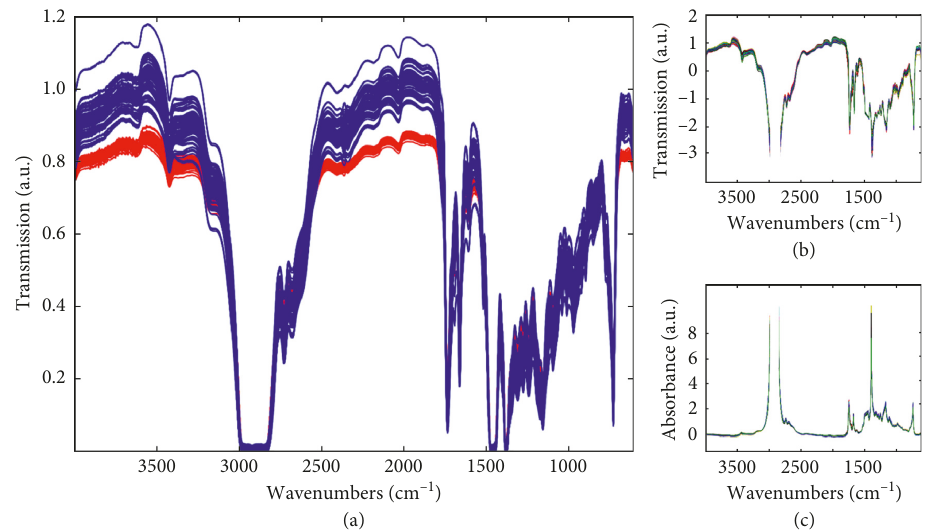
Figure 1: FTIR spectra of ATF. (a) Raw full transmission spectra without any preprocessing. The two data sets with different measurement setups can be discriminated by eye. The blue spectra originate from measurement type (1) with two KBr discs separated by a Teflon spacer, and the red set of curves originates from the cuvette measurement (2). (b) SNV-transformed transmission spectra after truncation of the saturated C-H vibrational regions and CO 2 areas and (c) SNV-transformed absorbance spectra after truncation.